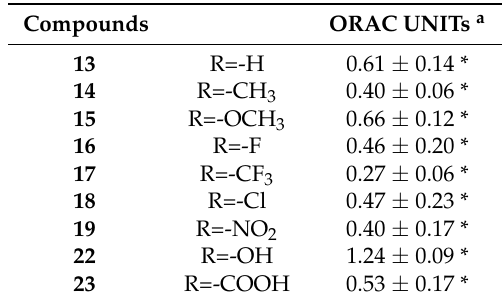
Table 1. Antioxidant activity of 4-thiazolidinones 13 – 19 , 22 and 23 .